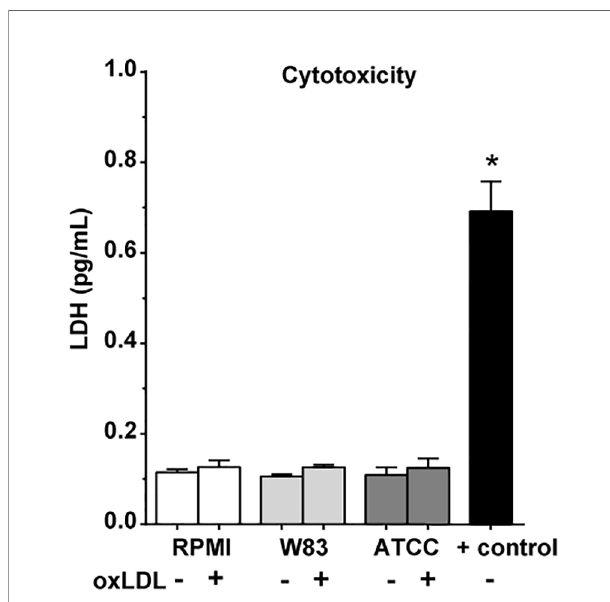
FIGURE 2 | Cytotoxicity of stimuli. Cell viability after 24h P. gingivalis and oxLDL costimulation (n = 6, *p < 0.05) measured with LDH cytotoxicity assay. Data are presented with mean ± SEM, p-values using Wilcoxon signed-rank test. oxLDL, oxidized LDL; W83, Pg W83 strain; ATCC, Pg ATCC strain; RPMI, medium control; + control, positive control for cell death.